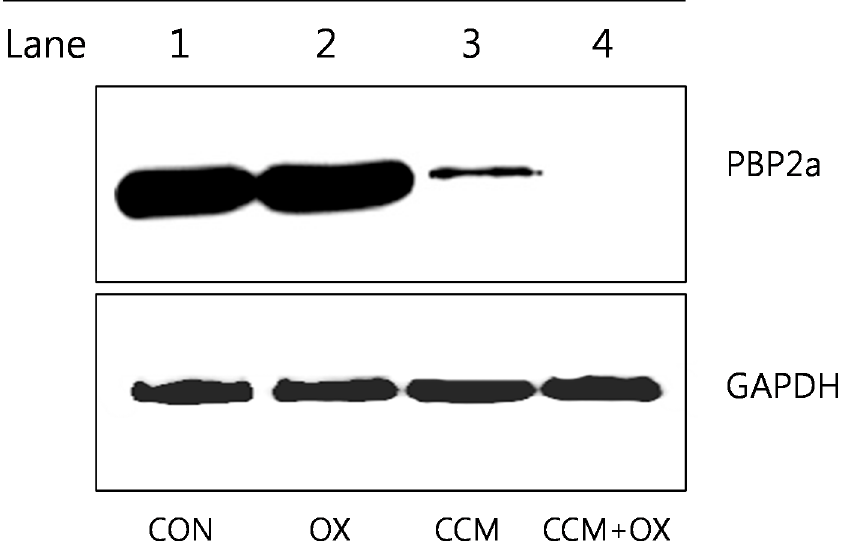
Figure 5. Western blot analysis of penicillin binding protein (PBP)2a production by ATCC 33591 after treatment with 32 µg/mL oxacillin (OX) and 250 µg/mL curcumin (CCM). The control (CON) was used without treatment drugs.